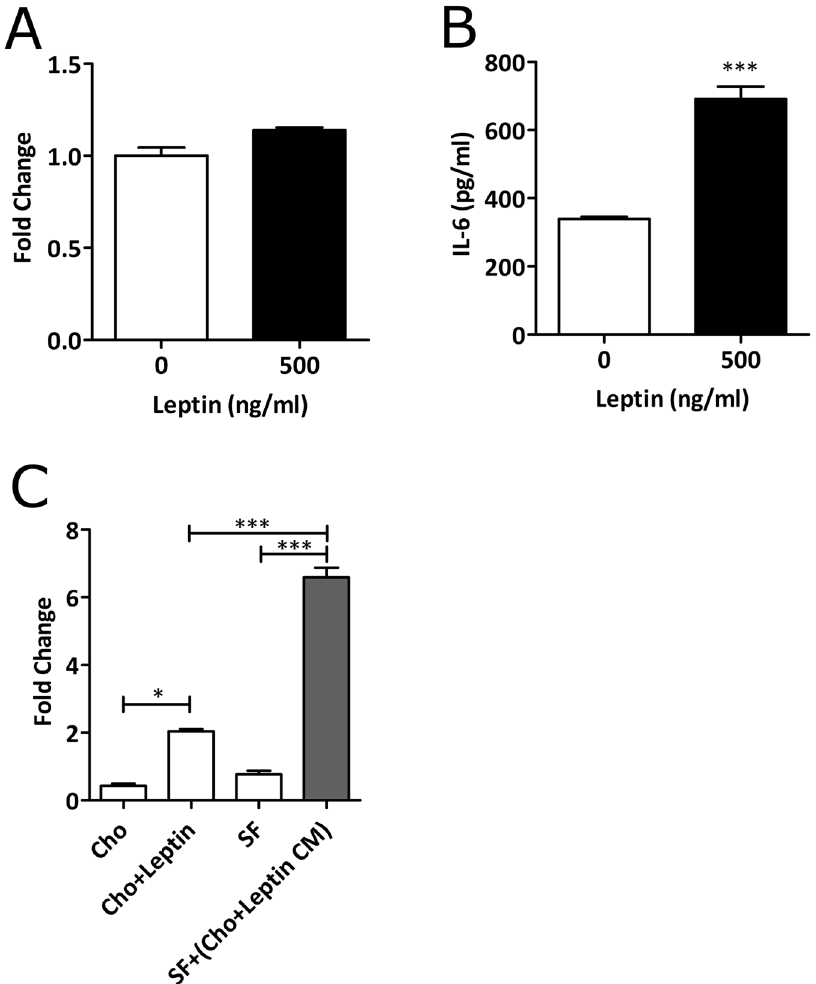
Secretion of IL-6 from chondrocytes stimulated with 500 ng/ml leptin. ( C ) Synovial fibroblasts cultured in leptin-stimulated chondrocyte conditioned media show enhanced IL6 secretion. IL6 expression was determined by ELISA. Data are mean ± SEM. Statistical significance was determined by Mann-Whitney U test and One- Way ANOVA where * p < 0.05, *** p <